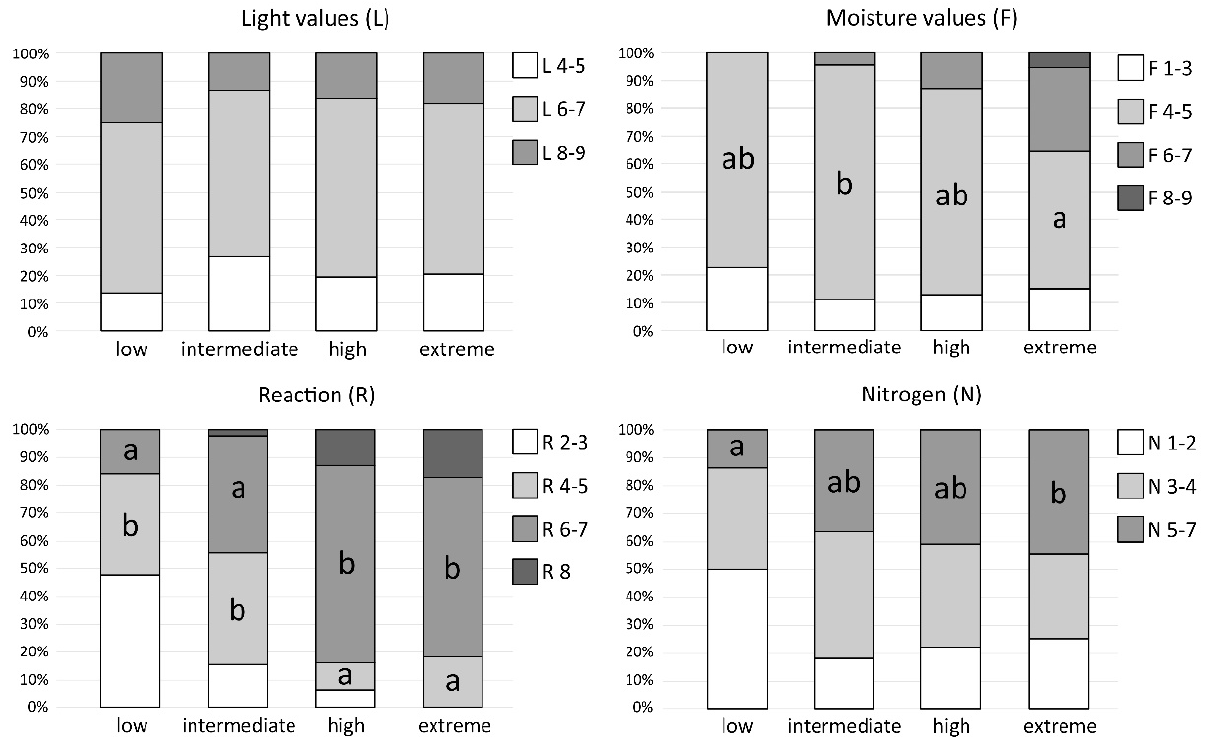
Figure 7. Composition of bryophytes in particular soil condition classes in the context of habitat requirements according to their ecological indicator values: light (L), moisture (F), reaction (acidity) (R), and nitrogen (eutrophication) (N) values. The results of Dunn’s post hoc test are provided when the Kruskal–Wallis test indicated significant differences between the soil condition classes; different letters within the bars indicate significant differences at the p < 0.05 level.